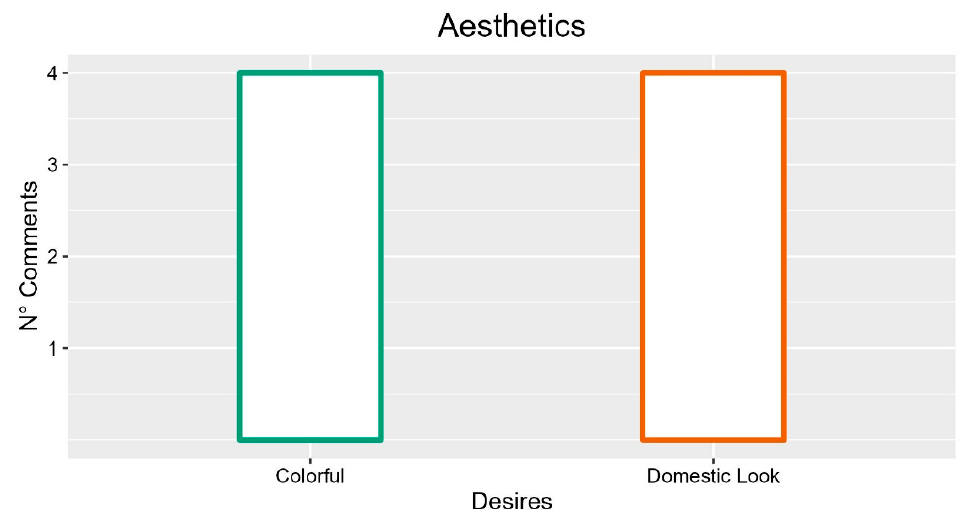
Figure 15. Graphical representation of desires with more occurrences in for the Aesthetics